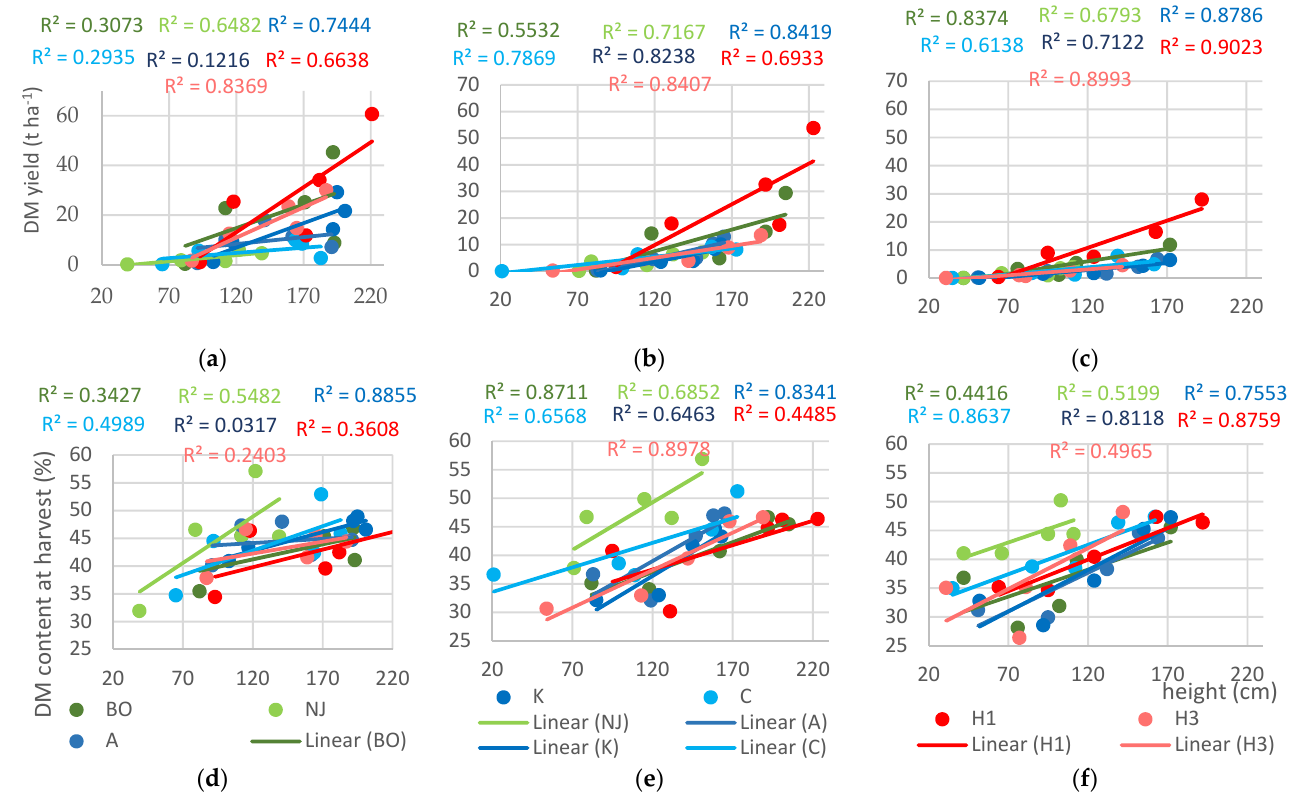
Figure 5. The linear course of dependence of dry matter yield on crop height ( a – c ) and dry matter content at harvest on crop height ( d – f ) according to treatments HA ( a , d ), NPK ( b , e ), and UC ( c , f ).